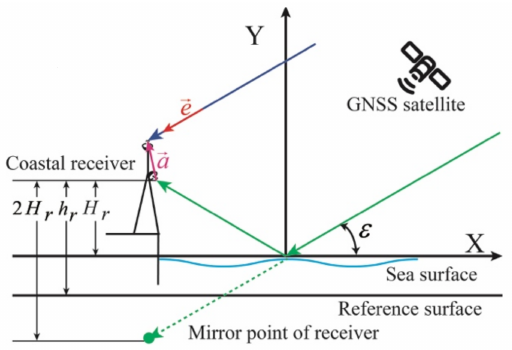
Figure 1. Bistatic geometry of the coastal GNSS-R ocean